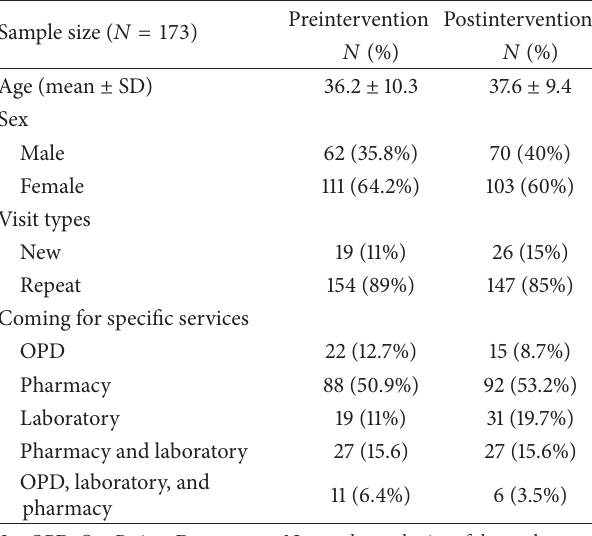
Table 1: Patient sample characteristics (preintervention and postin-